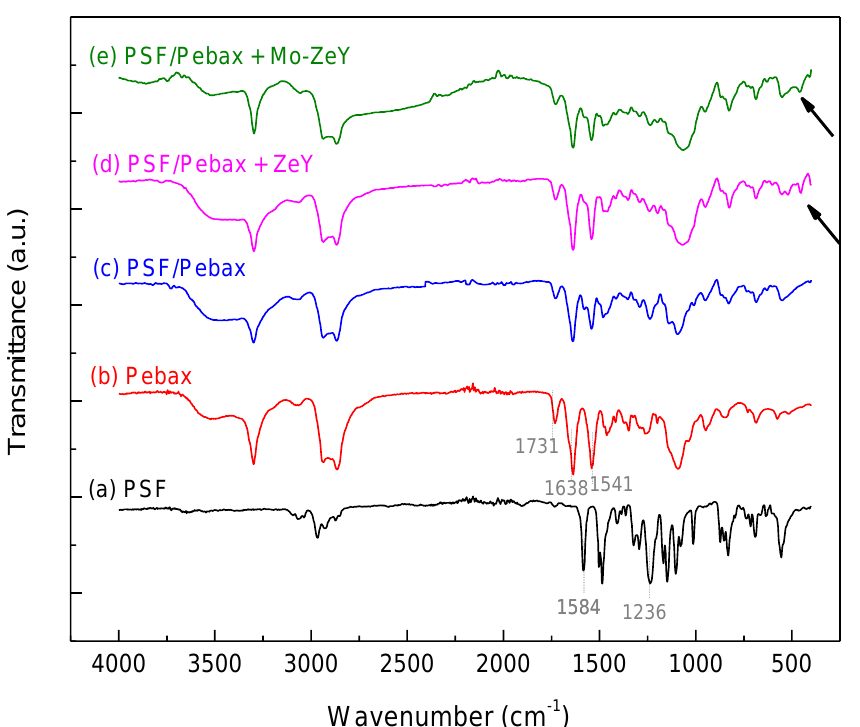
Figure 6. ATR-FTIR spectra of ( a ) PSF support, ( b ) Pristine Pebax, ( c ) PSF/Pebax composite mem- brane, ( d ) PSF/Pebax + 20 wt.% ZeY MMM, and ( e ) PSF/Pebax + 20 wt.% Mo-ZeY MMM. The two arrows indicate where new peaks are formed when ZeY or Mo-ZeY is incorporated with